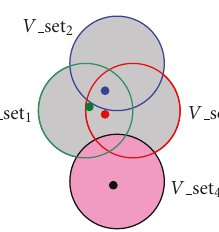
Figure 6: Venn diagram of four maxima and their voters: blue, green, and red are close maxima, and hence, members of the “ pool of winners ”. The black represents a far maximum. Each color circle represents a set of voters for a maximum with the same color.